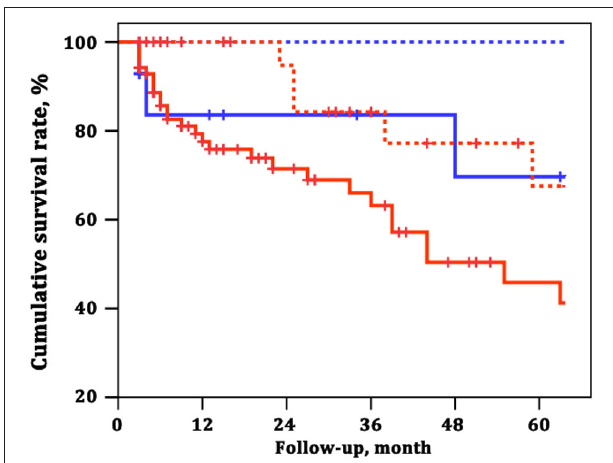
FIGURE 6 | Survival estimates of the four groups of patients based on the combination of French non-invasive low-risk criteria and attenuated right heart remodeling (ARHR). Blue dashed line represents French non-invasive criterion 3 and echo score 4.0–4.5. Red solid line represents French non-invasive criteria 0–2 and echo score 4.0–4.5. Blue solid line represents French non-invasive criterion 3 and echo score < 4.0. Red dashed line represents French non-invasive criteria 0–2 and echo score <